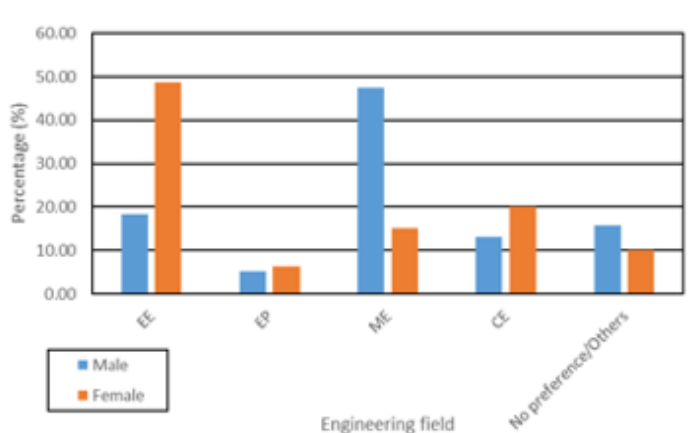
Figure 3. Field of engineering preferred by